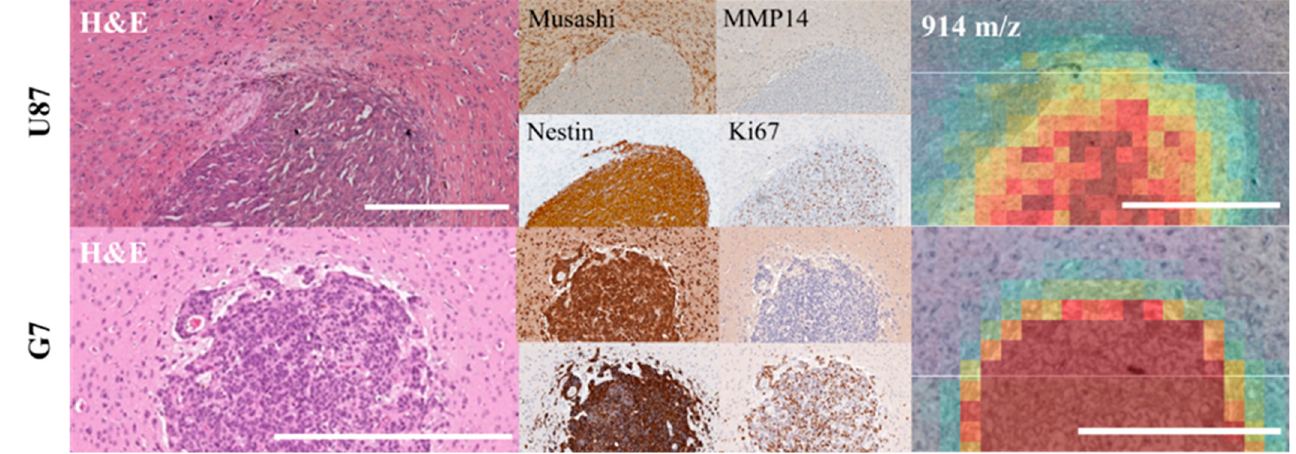
Figure 5. IHC staining in one representative tumor of both models (same markers for upper row: U87MG_mCherry, lower row: G7_mCherry, respectively). H&E, Musashi 1, MMP14, Nestin and Ki67 staining and MALDI mass intensity map (914 m/z ) of the same tumor region. Intensity relations of spectra are analogous with, e.g., MMP14-rich cell areas in U87MG-mCherry. Scale bars represent 0.5 mm.